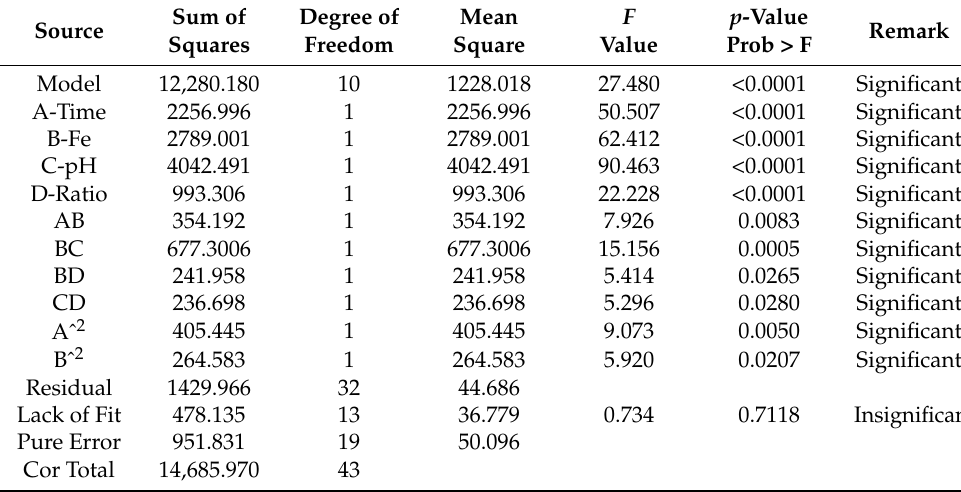
Table 9. Analysis of variance for color removal (reduced model).